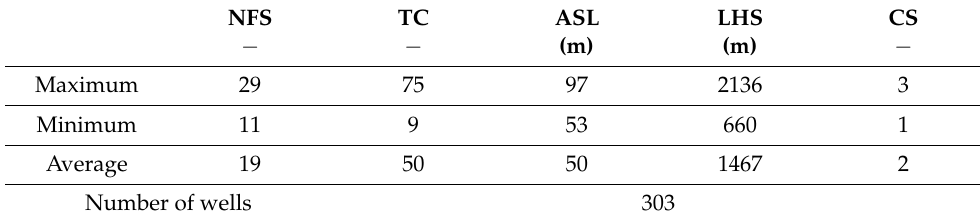
Table 1. Collection of process design parameters for horizontal wells.